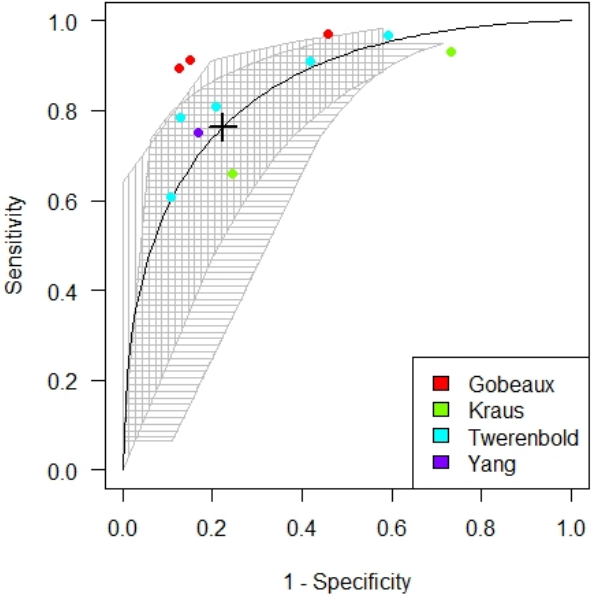
Figure 5. SROC curve for the optimized troponin T cut-off for patients not on dialysis. The cut-off value for cTnT for patients on dialysis was established at 240 ng/L (69.27; 410.23). The analysis consisted of 2 studies where Ryu provided 11 cut-off values and Yang 1 cut-off value. Ryu et al. used a cTnT, whereas Yang used an hs-cTnT assay. The sensitivity and specificity for the cut-off values were 0.88 and 0.92 respectively with an AUC of 0.96. See Figure 6.